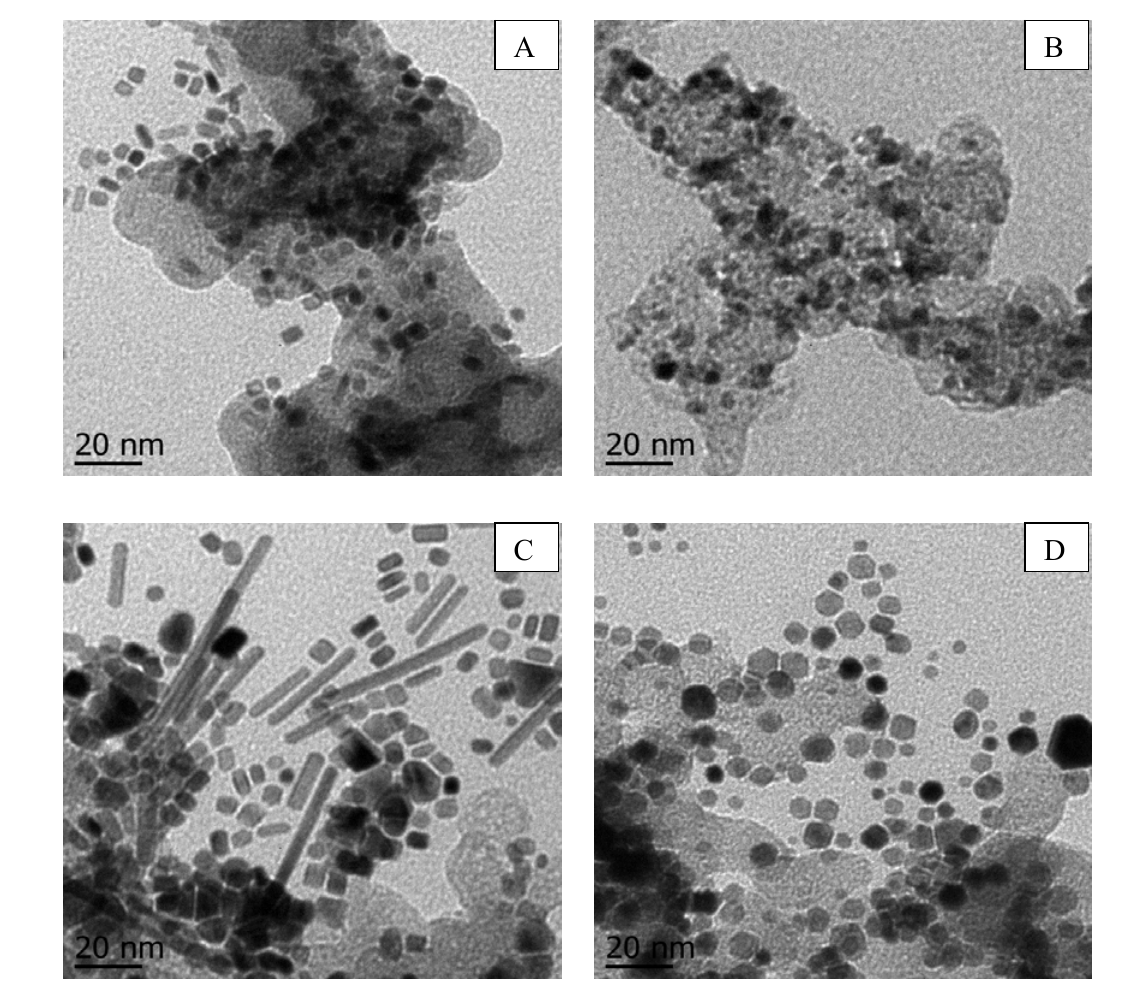
Figure 3. TEM images of ( A ) NB/C; ( B ) commercial Pd/C; ( C ) NR/C; and ( D ) NP/C